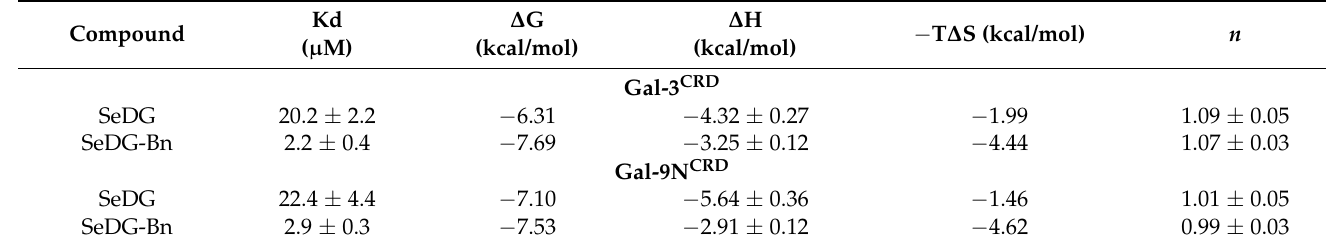
Table 1. In all cases, the n -values indicate a 1:1 ratio of galectin/inhibitor. The negative ∆ H suggests an exothermic reaction between the galectins and the ligands, while the positive ∆ S suggests entropically driven reactions involving hydrophobic interactions, especially in the case of SeDG-Bn. The introduction of the benzyl group at position C3 of SeDG-Bn (Kd~2 µ M) leads to a ~10-fold enhancement of the binding affinity for both proteins compared to the SeDG (Kd~20 µ M), underlying the importance of the substitution. The enhanced binding affinity of SeDG-Bn to Gal-3 CRD and Gal-9N CRD with respect to SeDG is reflected in a small change in the binding free energy ( ∆∆ GSeDG-Bn/SeDG of − 1.38 kcal/mol and –0.4 kcal/mol,